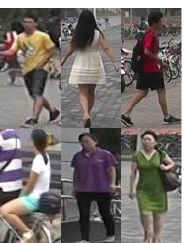
Figure 5. RAiD dataset exemplary samples.